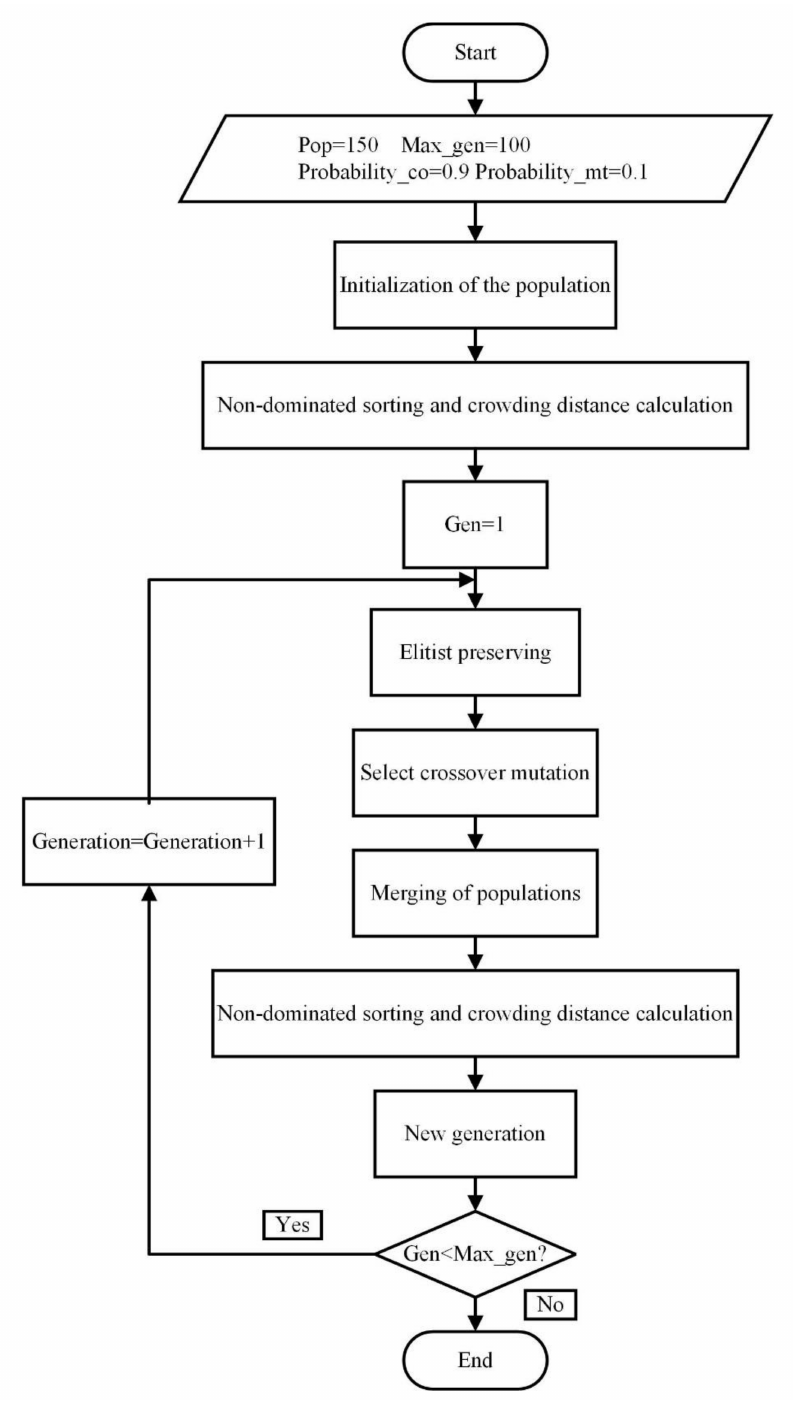
Figure 3. Solving procedure for NSGA-II using plate-fin heat exchanger